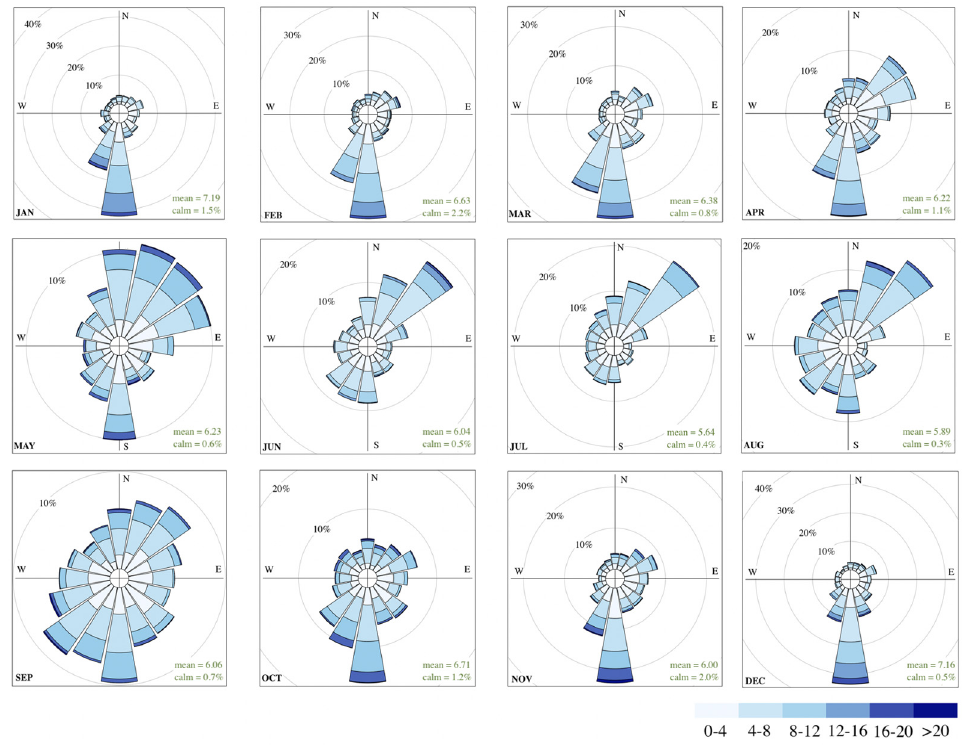
Figure 3. Seasonal wind distribution analysis for the weather station “The Island of Dikson” (WMO ID: 20674) for 15 yrs. of observations (2005 – 2020): frequency of counts (%) and speed (m/s).